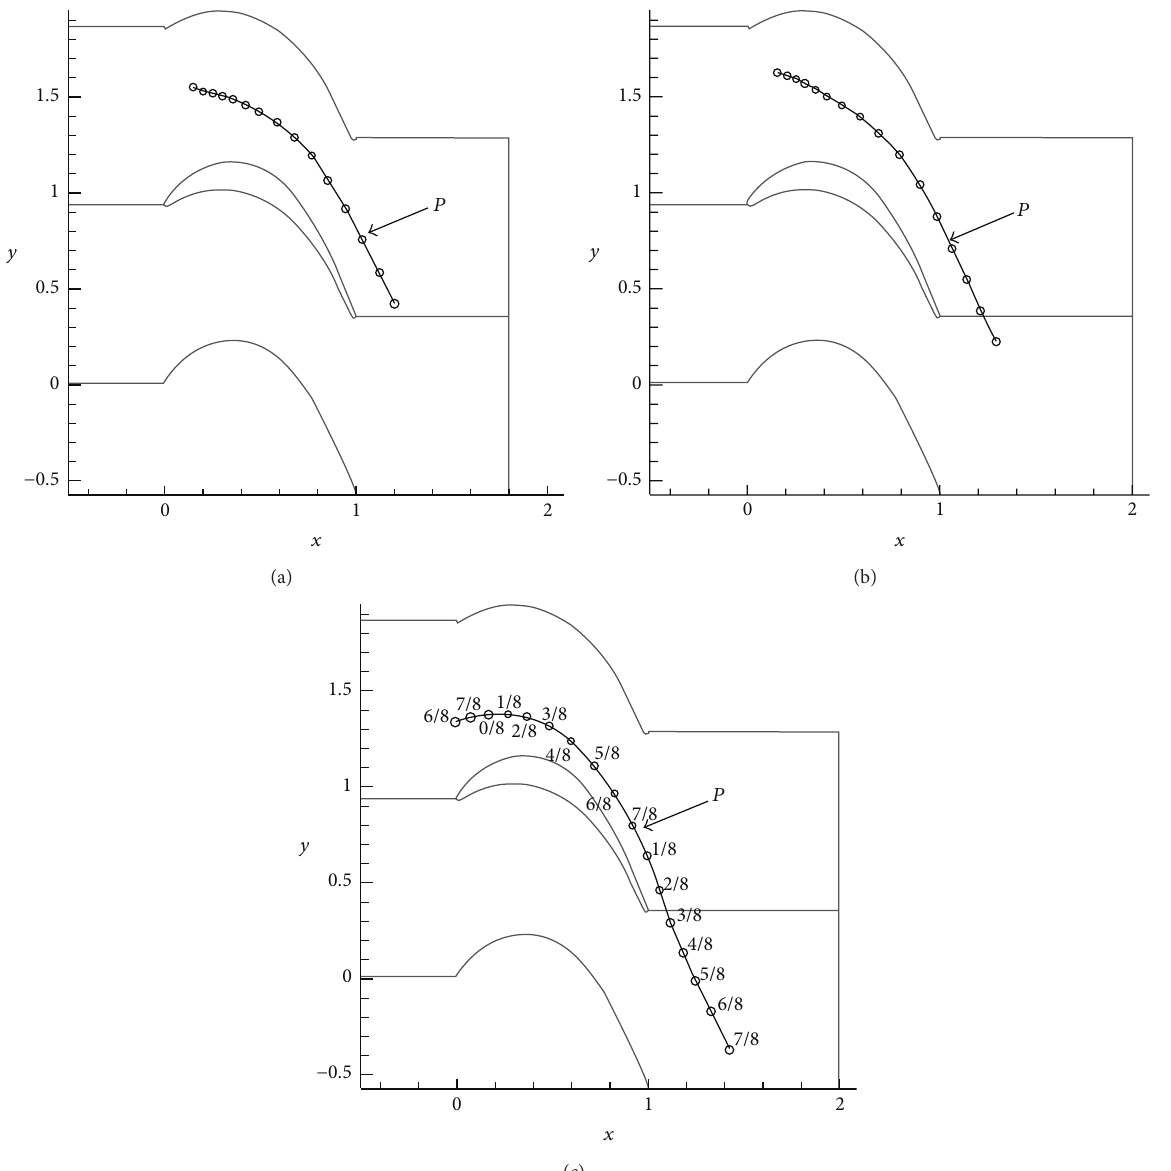
Figure 4: Approximate path of the peak of turbulent kinetic energy in the blade vane: (a) LES: Re = 5.18 × 10 4 , (b) DNS: Re = 5.18 × 10 4 , and (c) LES: Re = 1.48 × 10 5